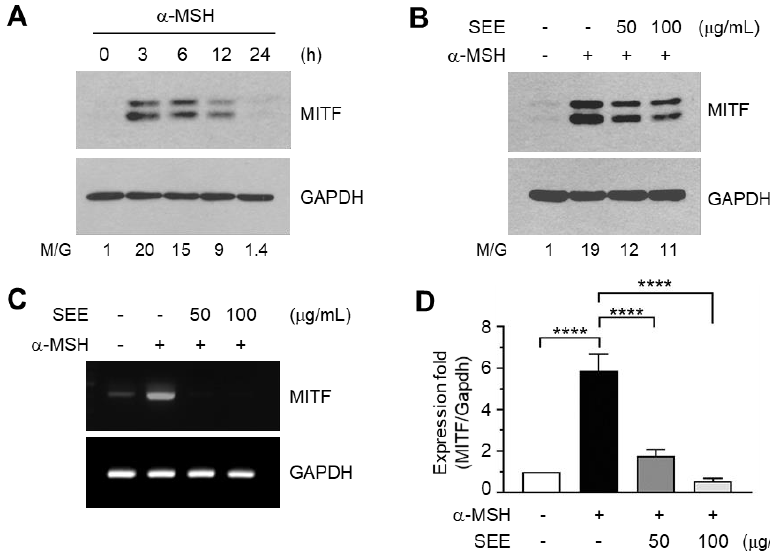
Figure 3. Effect of SEE on the downregulation of α -MSH-induced microphthalmia-associated transcription factor (MITF) expression. ( A ) B16F10 cells were treated with 100 nM α -MSH for various times (0–24 h), and cell lysates were subjected to immunoblotting using antibodies against MITF. GAPDH level was examined as an internal control. The intensity of the bands was quantified using ImageJ and the relative MITF intensity was normalized to that of GAPDH and visualized in the blot. M/G, MITF/GAPDH. ( B – D ) B16F10 cells were treated with either vehicle (DMSO), 50 or 100 µ g/mL SEE for 30 min, followed by stimulation with 100 nM α -MSH. (B) After 6 h, the cell lysates were subjected to immunoblotting using antibodies against MITF. GAPDH level was examined as an internal control. ( C , D ) After 3 h, total RNA was isolated and MITF mRNA was measured by RT-PCR ( C ) and quantitative real-time PCR ( D ). The GAPDH mRNA level was examined as an internal control. The data shown represent the mean ± SD ( n = 3). **** p < 0.0001.